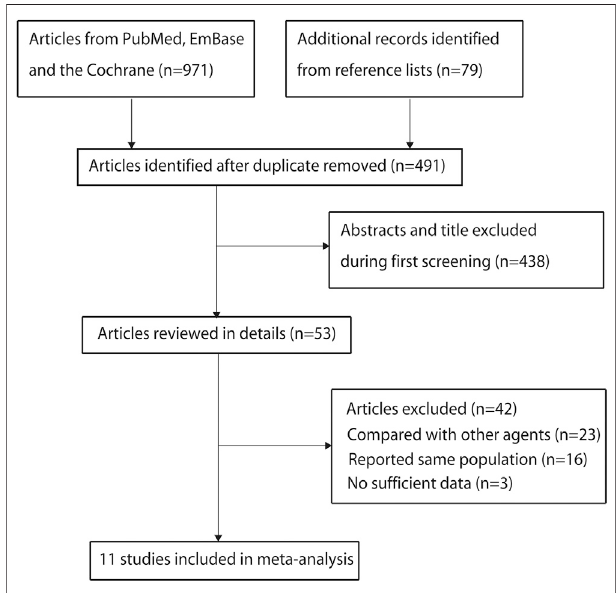
FIGURE 1 | Flow diagram of study identi fi cation, and inclusion and exclusion